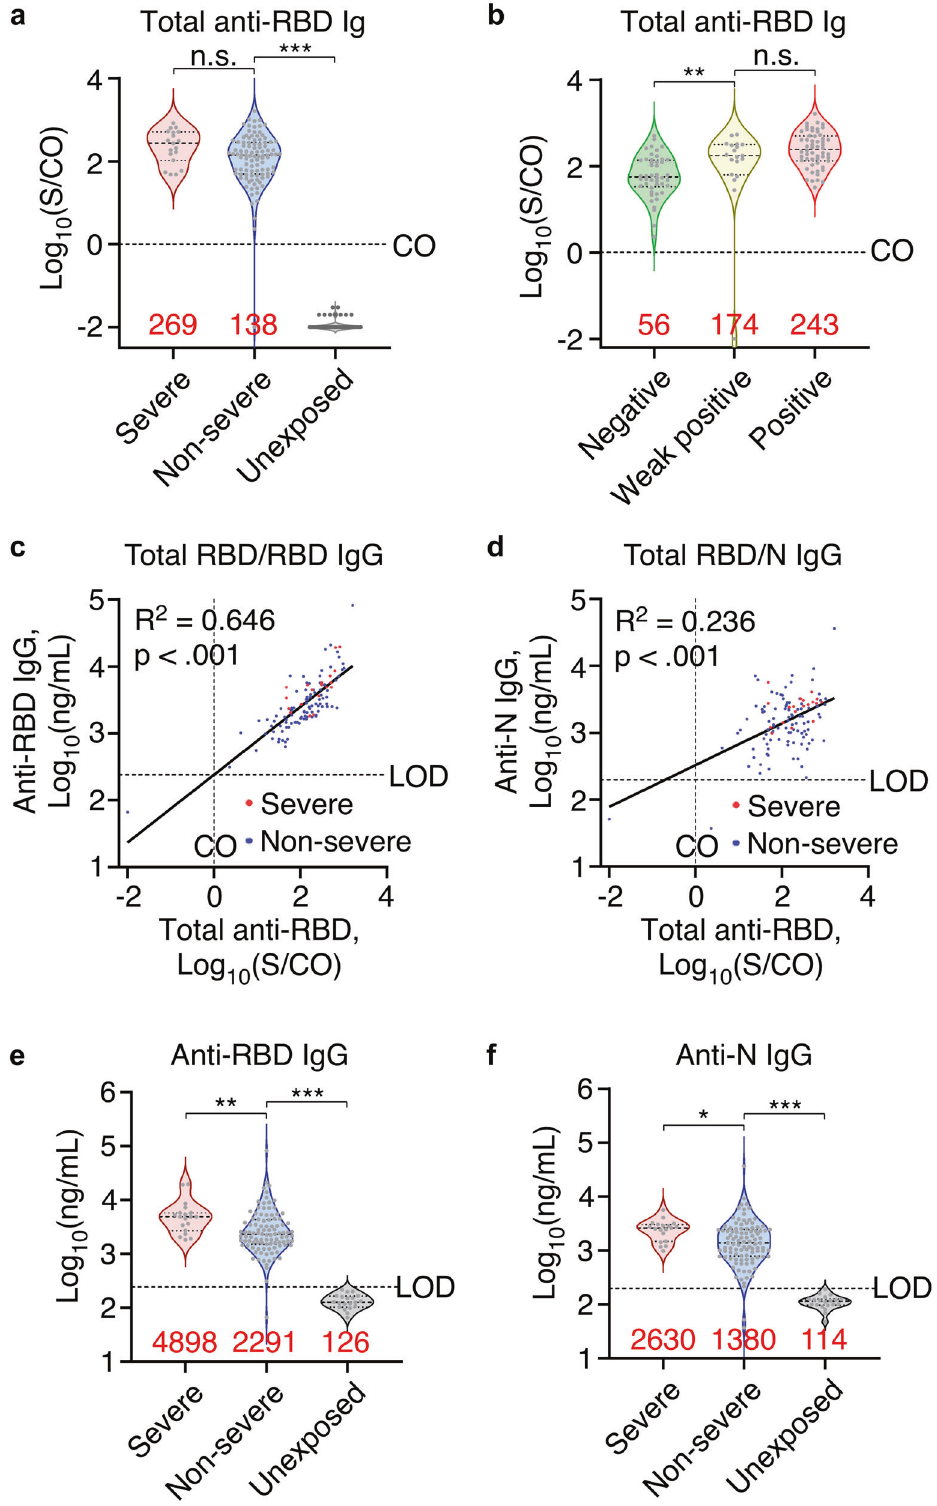
Fig. 1 Long-lasting SARS-CoV-2 antibody response 1-year after infection. a Total anti-RBD antibodies in non-severe ( n = 102) and severe patients ( n = 19) sera 10 – 12 months after infection and in unexposed population ( n = 100) measured by CMIA. CO, cutoff value. b Total anti- RBD antibodies in sera of participants with SARS-CoV-2 GICA negative ( n = 46), weak positive ( n = 19), or positive ( n = 56) results. c , d Scatter plot showing linearity of total anti-RBD antibodies with anti-RBD IgG ( c ) or anti-N IgG ( d ). Linear regression was performed on all datapoints. n = 121. e , f Anti-RBD ( e ) and anti-N IgG ( f ) concentrations in non-severe ( n = 102) and severe patients ( n = 19) 10 – 12 months after infection and in unexposed population ( n = 20) measured by ELISA. Red numbers indicate median value for violin plots. Dotted lines indicate the diagnostic cut-off (CO) for total anti-RBD antibody titers or the limit of detection (LOD) for anti-RBD or anti-N IgG concentrations. * p < .05, ** p < .01, *** p < .001, n.s. not signi fi cant Signal Transduction and Targeted Therapy (2021)